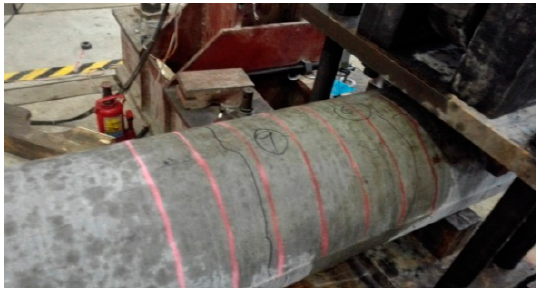
Figure 7. The crack development of PHC tube column specimen during loading.